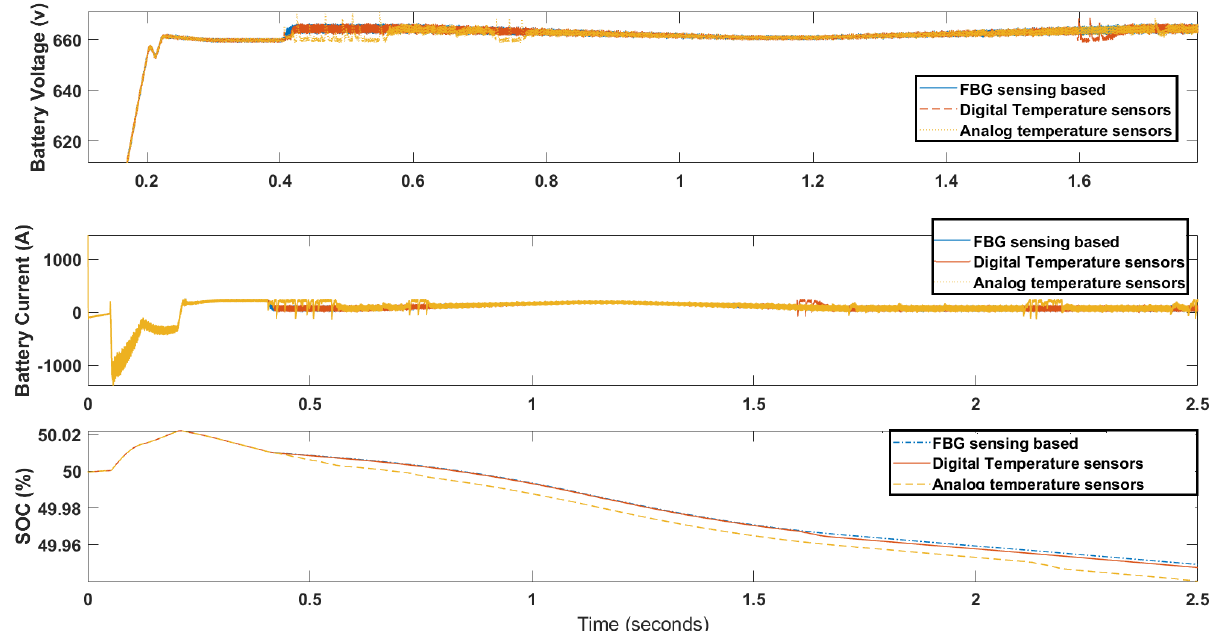
Figure 14. Output metrics at the potential point of the battery bank.